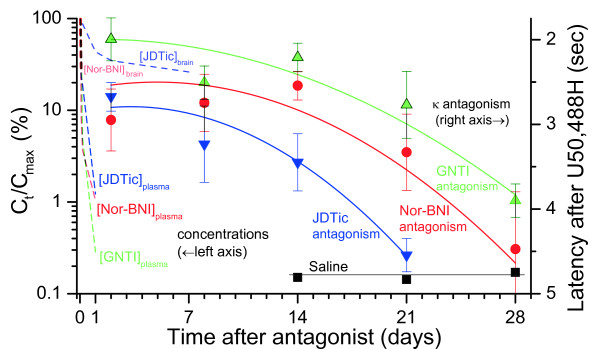
Elimination of nor-BNI, GNTI and JDTic from brain and plasma compared to the reported durations of κ antagonism at the same dose (mean ± 95% CI, 10 mg kg-1i.p. in mice, tail flick assay[18]).